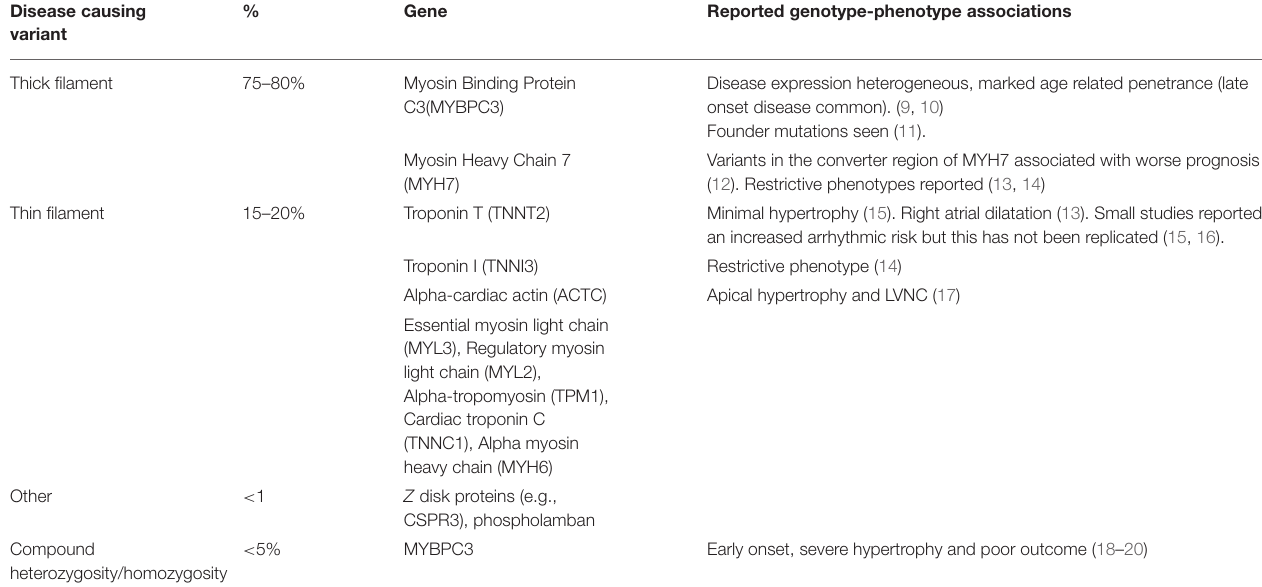
TABLE 1 | Reported genotype-phenotype correlations in hypertrophic cardiomyopathy. Disease causing